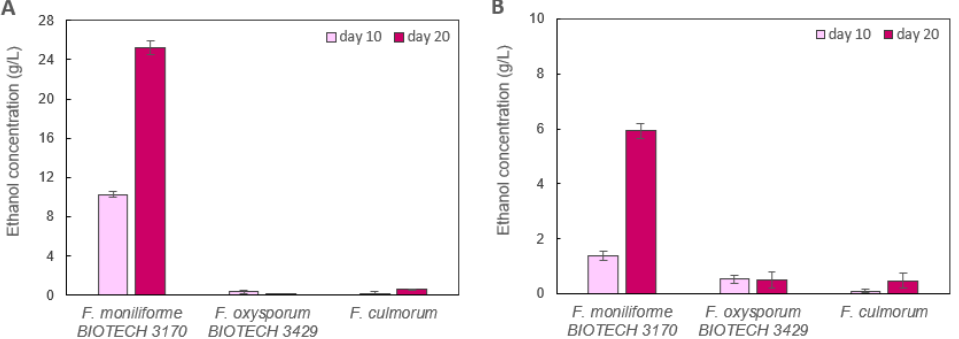
Figure 2. Ethanol production from cellulose at ( A ) solid-state and ( B ) submerged conditions by various fungi after 10 and 20 days.